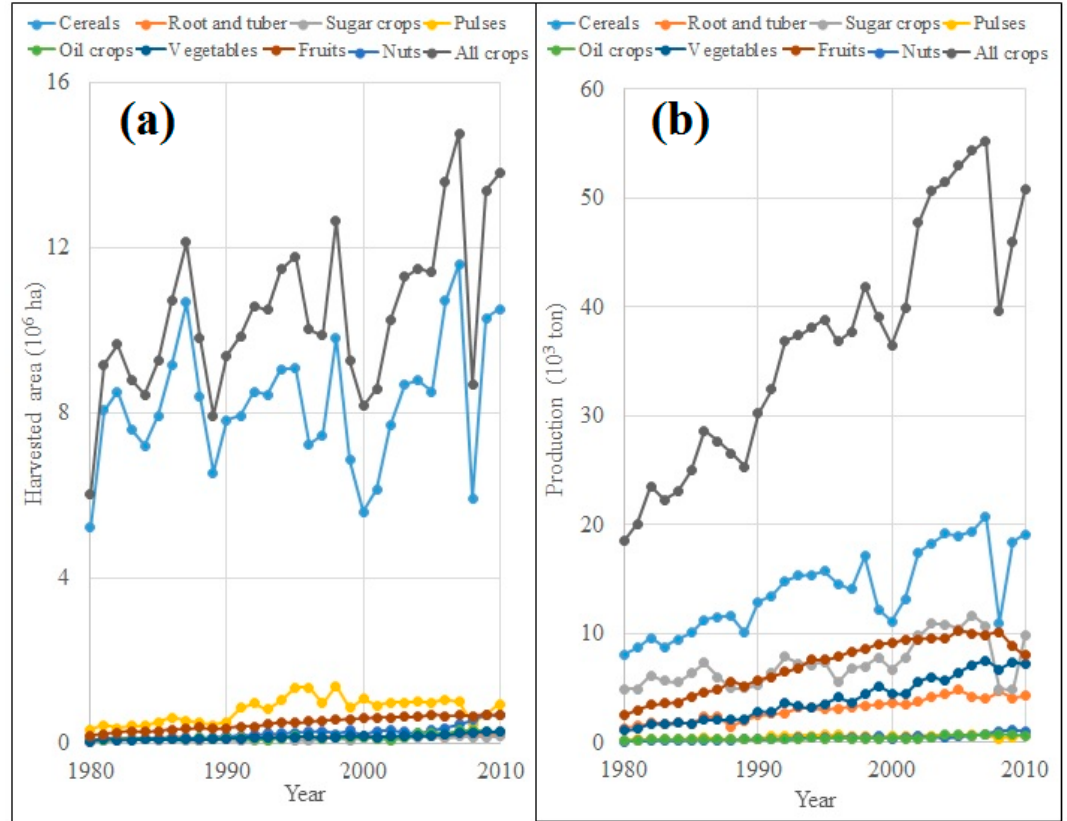
Figure 2. Harvested area ( a ) and production ( b ) in Iran per crop category over the period 1980–2010.